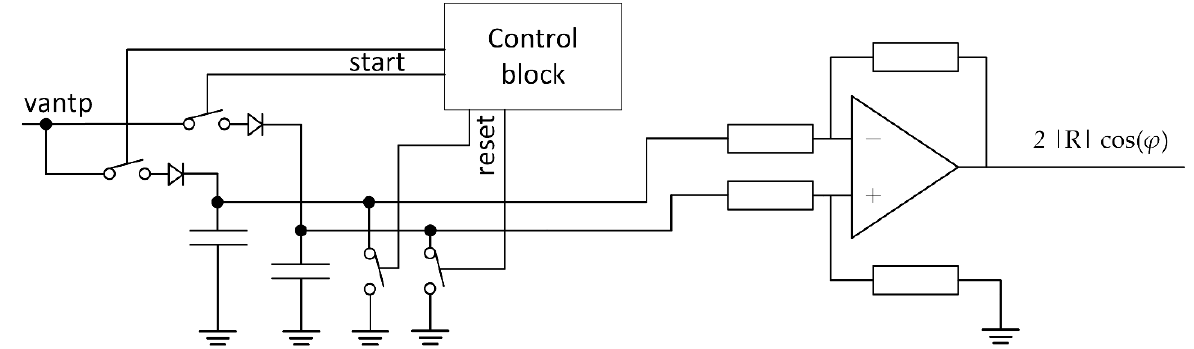
Figure 11. Circuit for amplitude difference measurement corresponding to the equation (9).